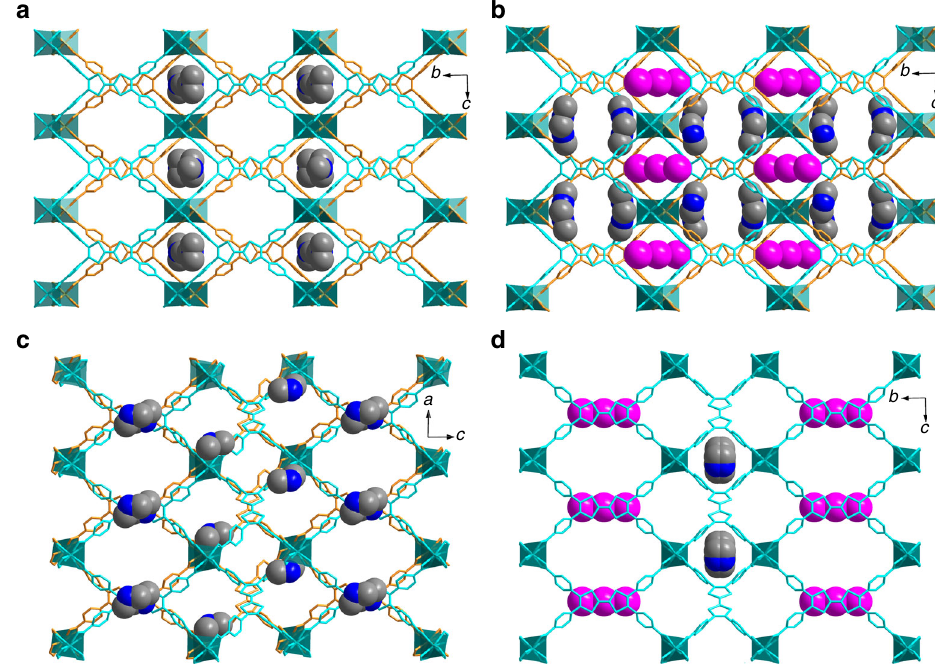
Fig. 3 Crystal structure changes upon I 2 treatment. a , b Structural transformations of 1 and I 3 − @ 1 ; c , d guest location in the single-crystal structures of 2 , and I 3 − @ 2 . Two sets of interpenetrated networks were colored blue and orange. Color scheme of guest species: I, purple; N, blue; C,